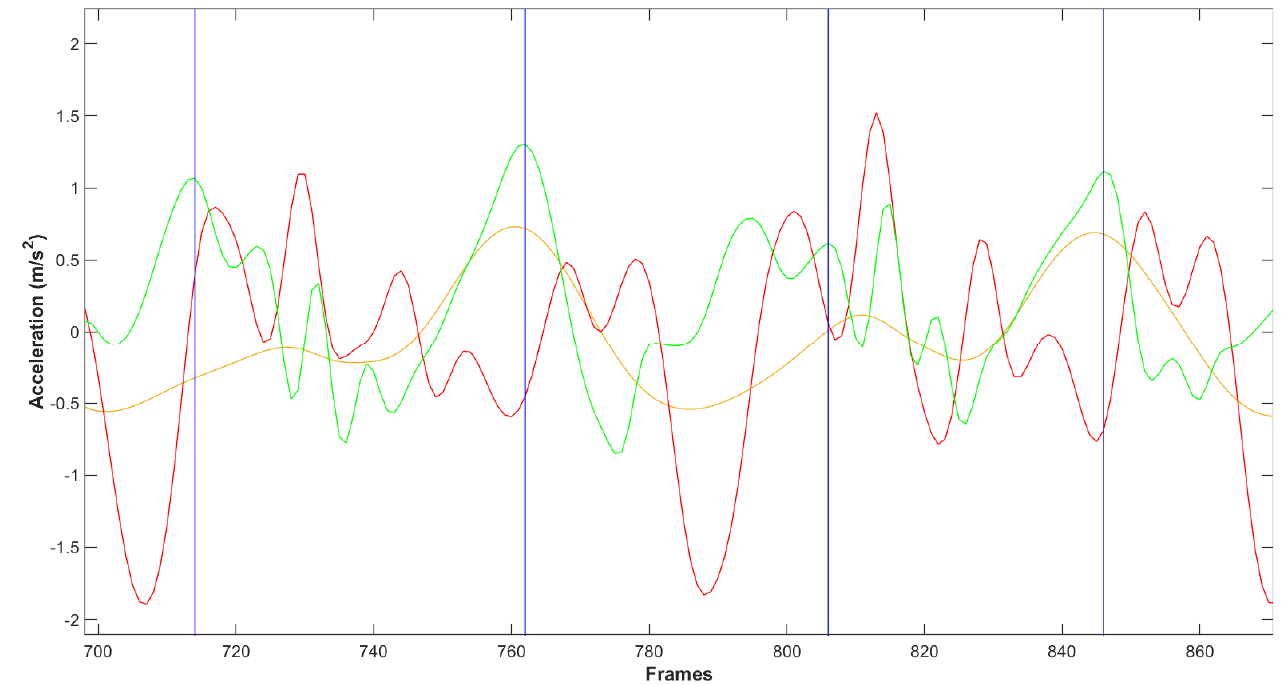
Figure 2. Filtered smartphone signals over time. Medio-lateral acceleration (yellow curve), vertical acceleration (red curve), and anterior–posterior (AP) acceleration (green curve) were used to identify ground truth foot strikes. Typically, foot strikes correspond with an AP acceleration peak followed by a vertical acceleration peak. Video recording of the trial was used to confirm the timestamp of foot strikes. Vertical blue lines indicate frames manually identified as ground truth labels.